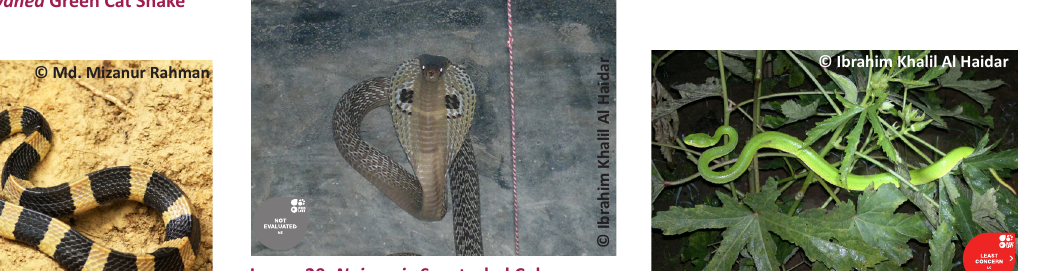
Image 18. Naja kaouthia Monocled